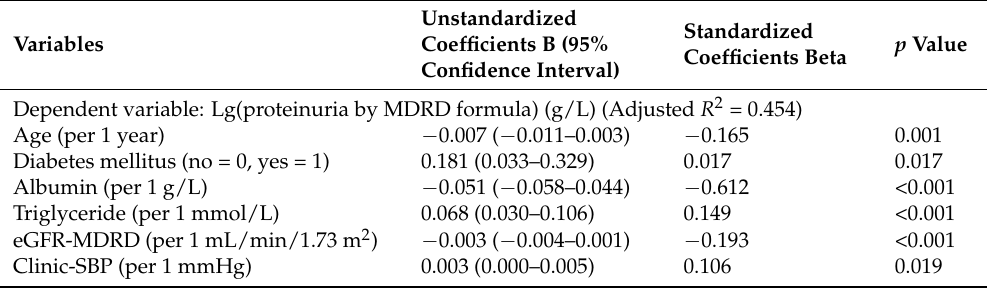
Table 5. Multivariable linear regression analysis for